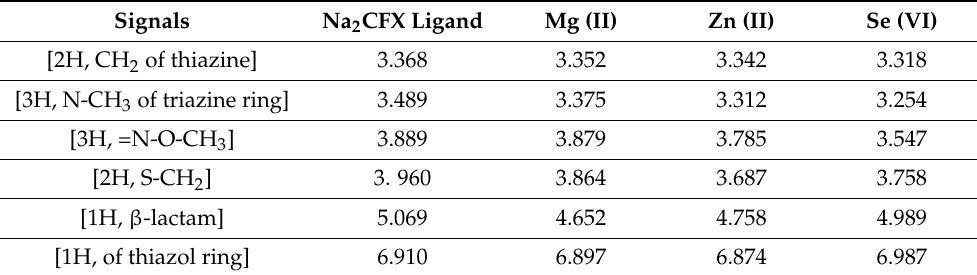
Table 4. HNMR spectral assignments of ceftriaxone and its